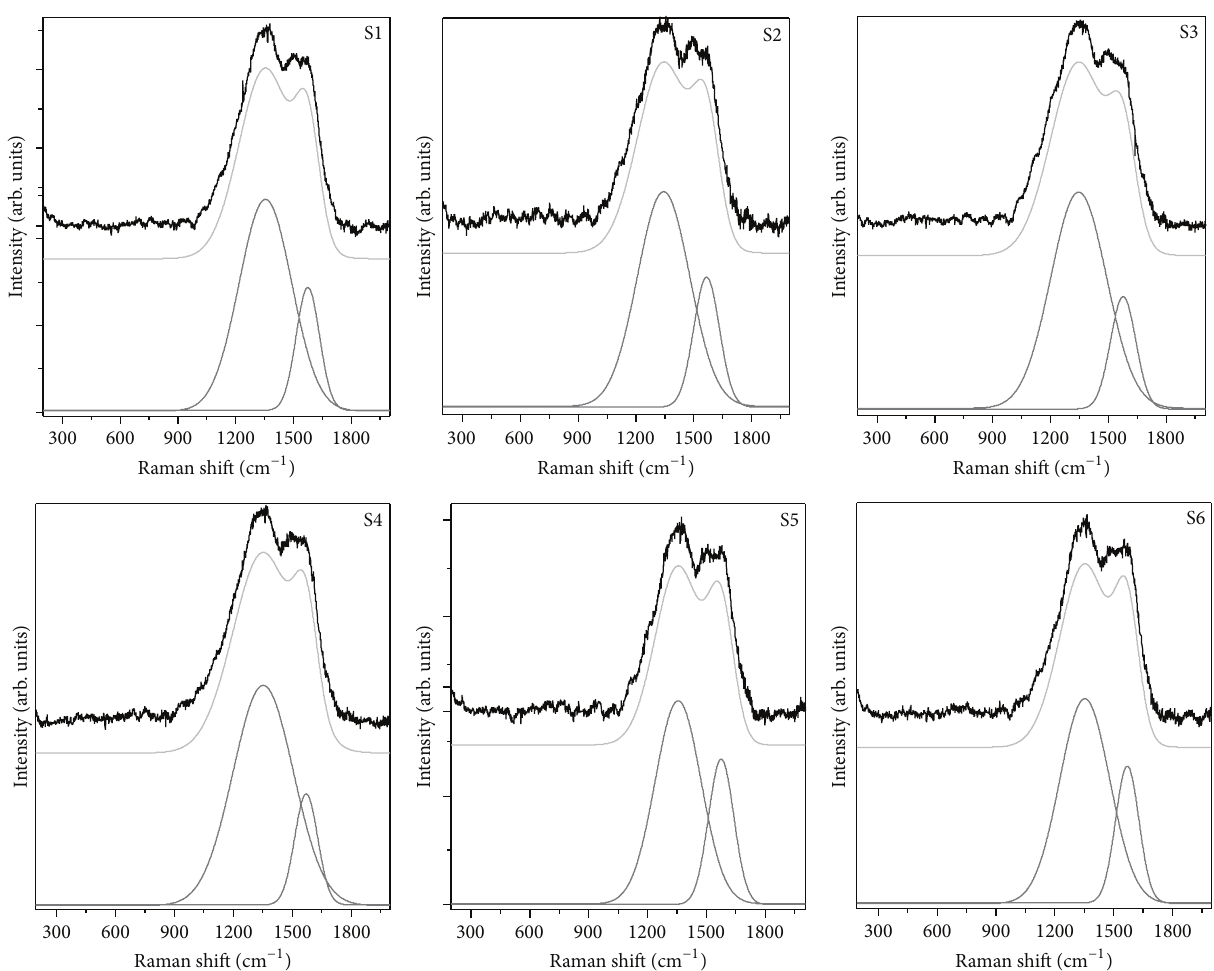
Figure 3: Raman spectra of the S1–S6 series of the 𝛼 -CN 𝑥 films deposited on glass as substrate and their corresponding fitted Lorentz